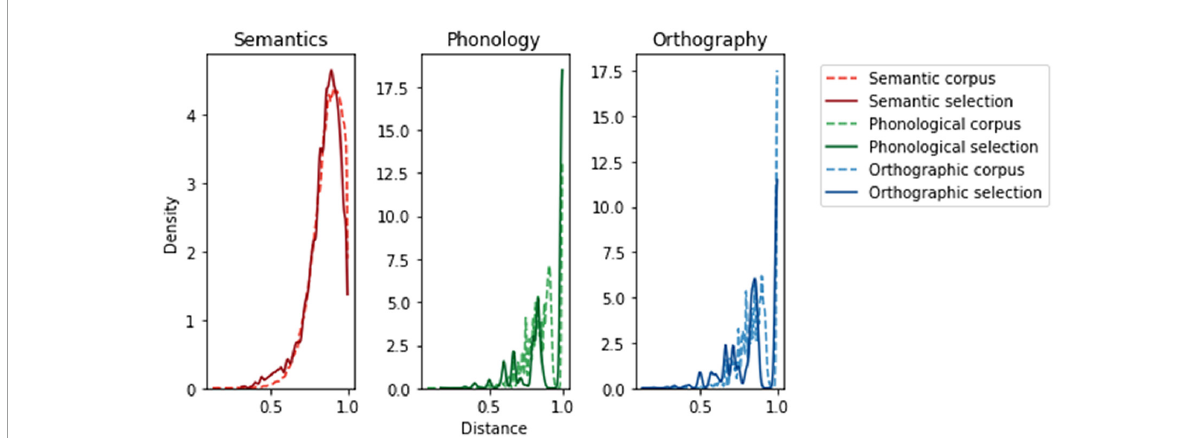
FIGURE2 Comparison of the distributions of distances in our sample of items within the larger corpus to our stimulus selection, showing high congruence. The corpus distributions were calculated using 78.120 pairs (between 280 unique words) from our sources for semantic, phonological and orthographic model representations (see under “Computational models”). The y axis scale differs between modality as the integral of a probability density function equals 1, and the “peaks” in the form modalities are narrower due to a discrete amount of possible Levenshtein values for the word lengths in our set. The shape of the distribution is more informative than the absolute y values. The word selection favors slightly more close pairs than the corpus as seen by the larger area under the left part of each modality’s selection curve.